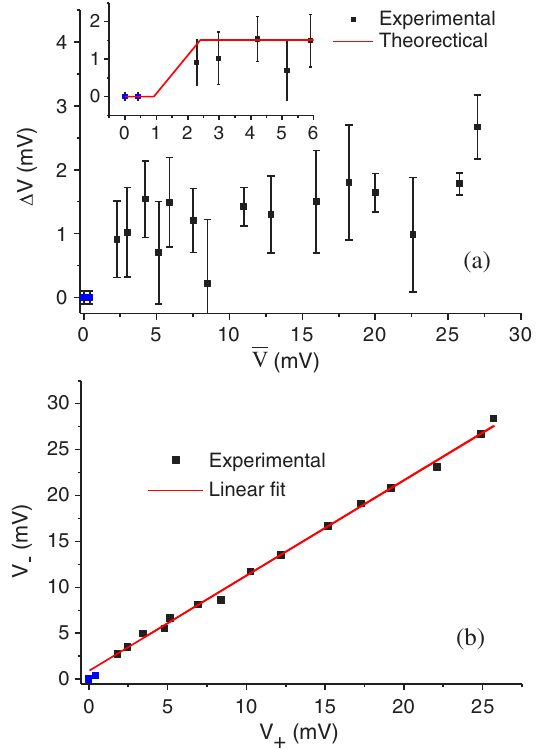
FIG. 4 (color online). (a) The asymmetry of potential drops ¯ V ( Δ V ) as a function of the averaged potential drop ( ) at the junction between forward and reverse biases. Inset: Measured and ¯ V calculated upper bound of Δ V at low . (b) The potential drop at reverse bias ( V − ) as a function of potential drop at forward bias ( V ) at the junction. Data points shown in blue color correspond þ to those measured with a bias voltage of less than 0.5